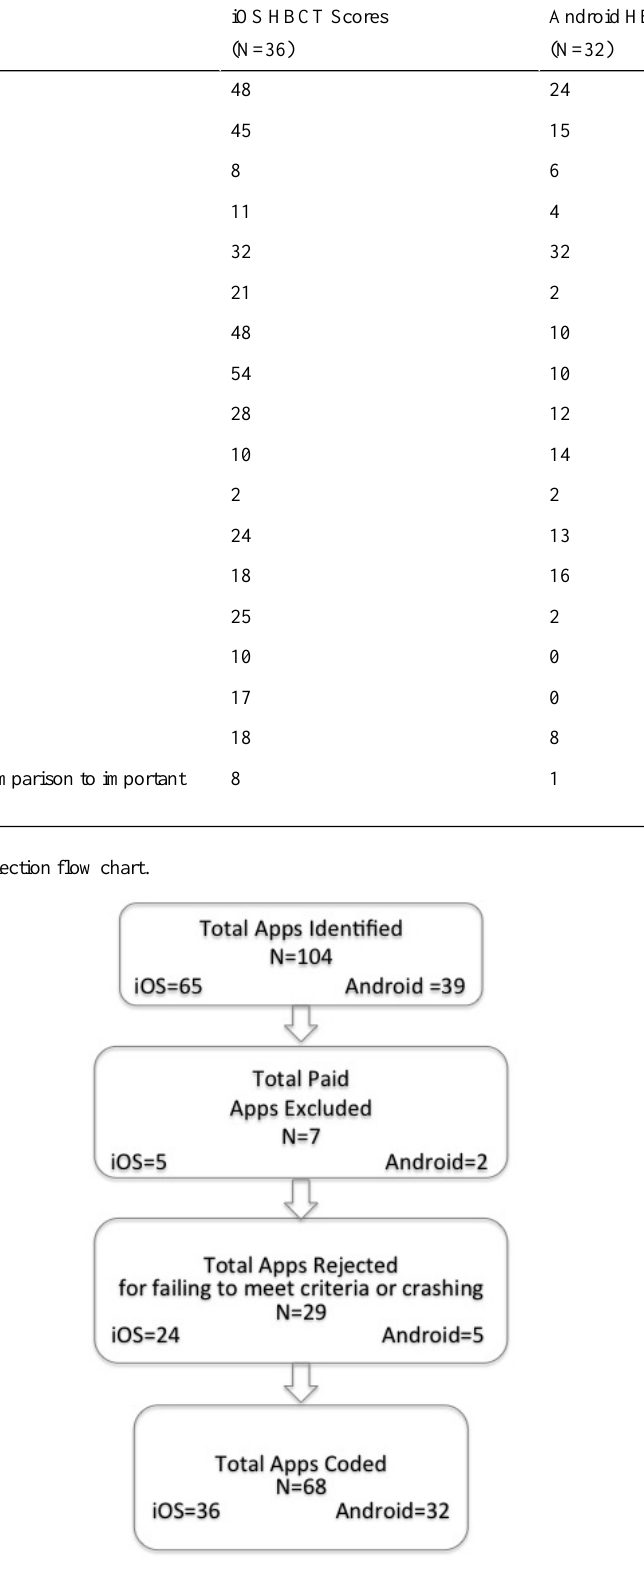
Percentages of Health Behavior Change by Category The percentage of HBCTs for each category of both the iOS and the Android platforms is shown in Table 3. A discussion